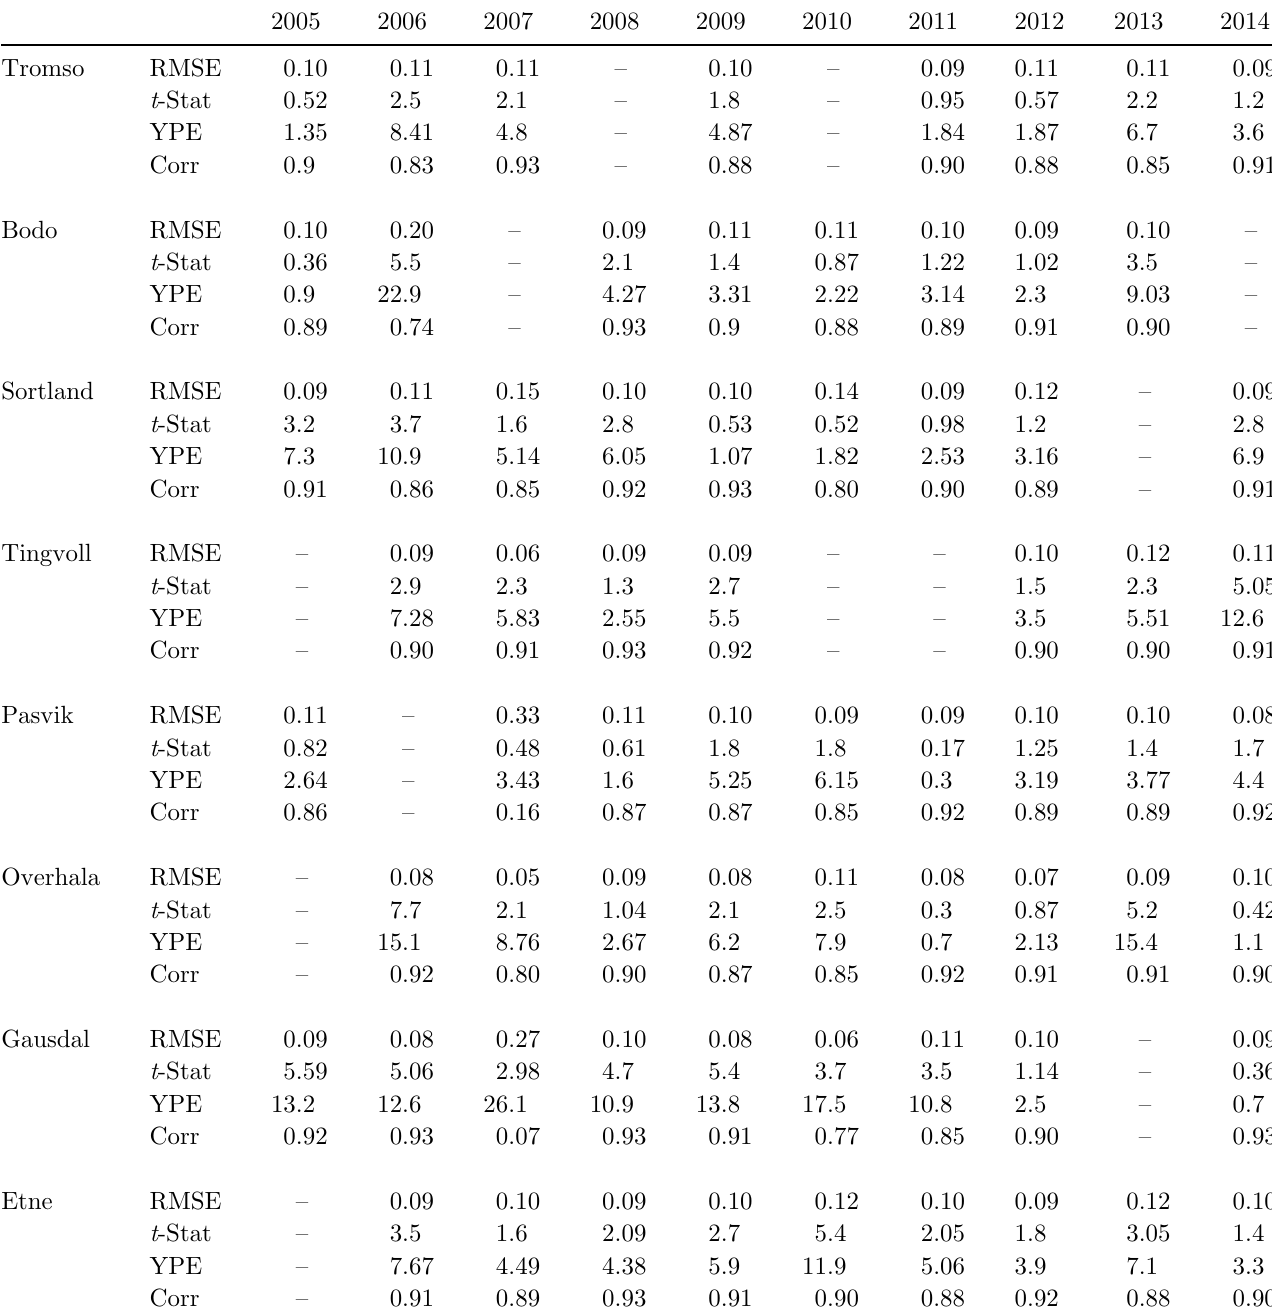
Table 1. Statistical performance parameters for the